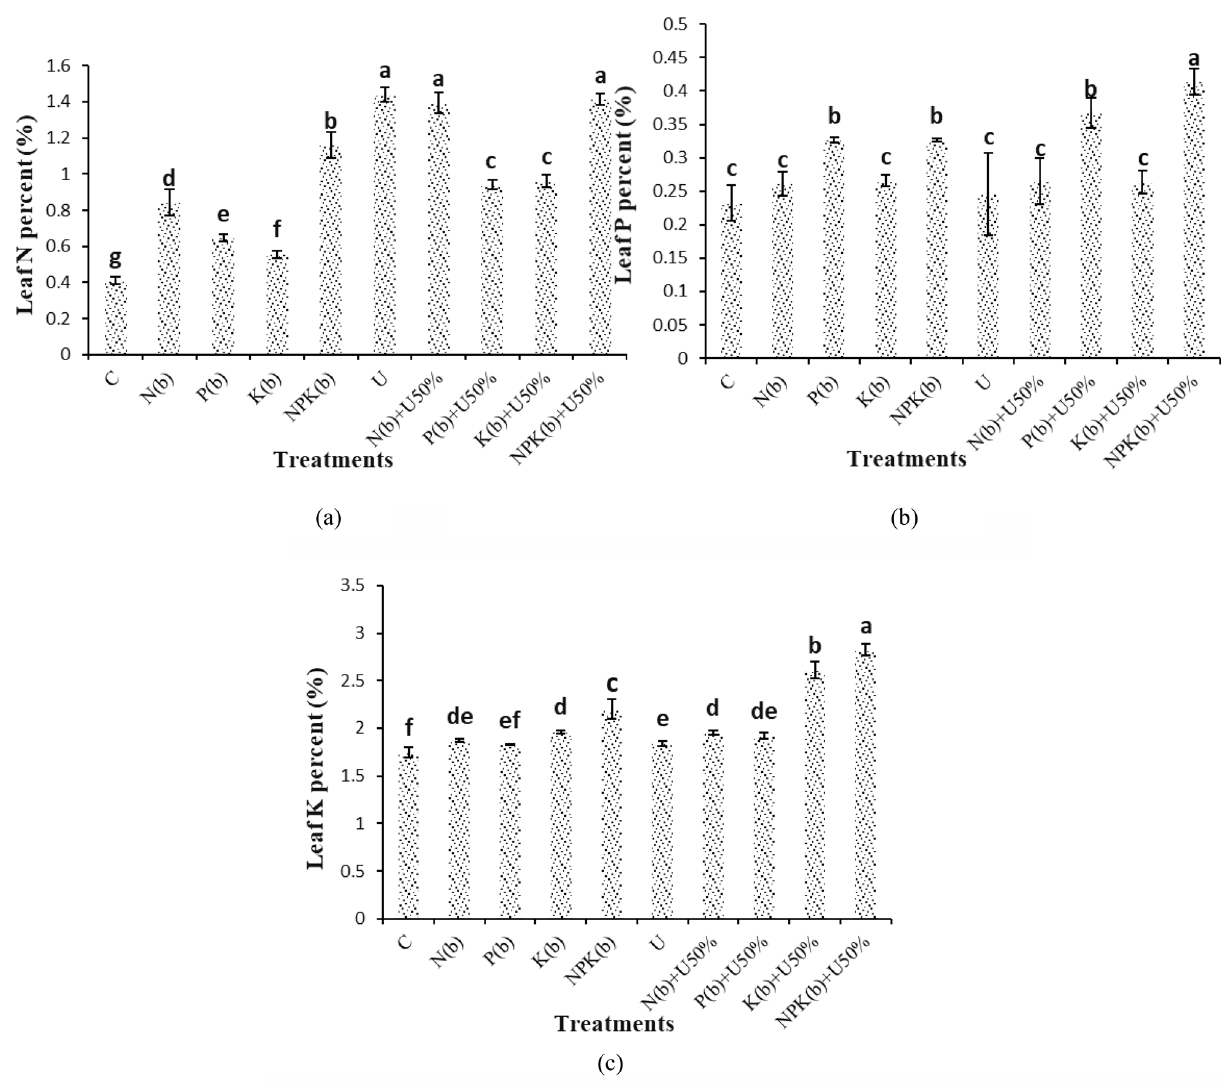
Figure 8. Means comparison for leaf N content, leaf P content and leaf K content of Nigella sativa L. as influenced by biofertilizers and urea. Dissimilar letters show significant differences at the p ≤ 0.01 level. Control (C), U Chemical urea, Nb (biological N), Pb (biological P), Kb (biological K, NPKb (mixed biological NPK), Nb + U50%, Pb + U50%, Kb + U50%, and NPKb +